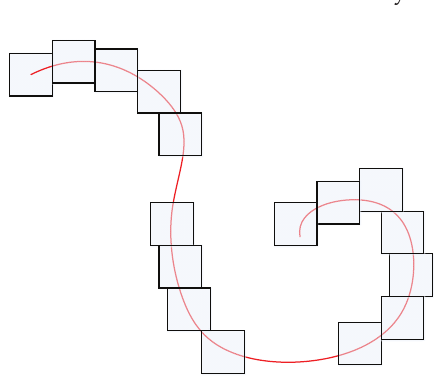
Figure 5: An example of path clustering with three